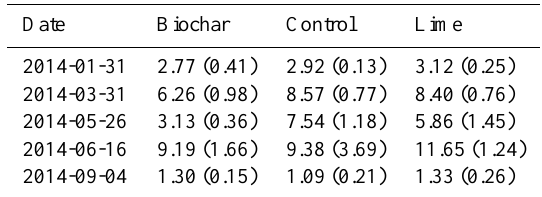
+ -Nkg − 1 ) in soil during the 4